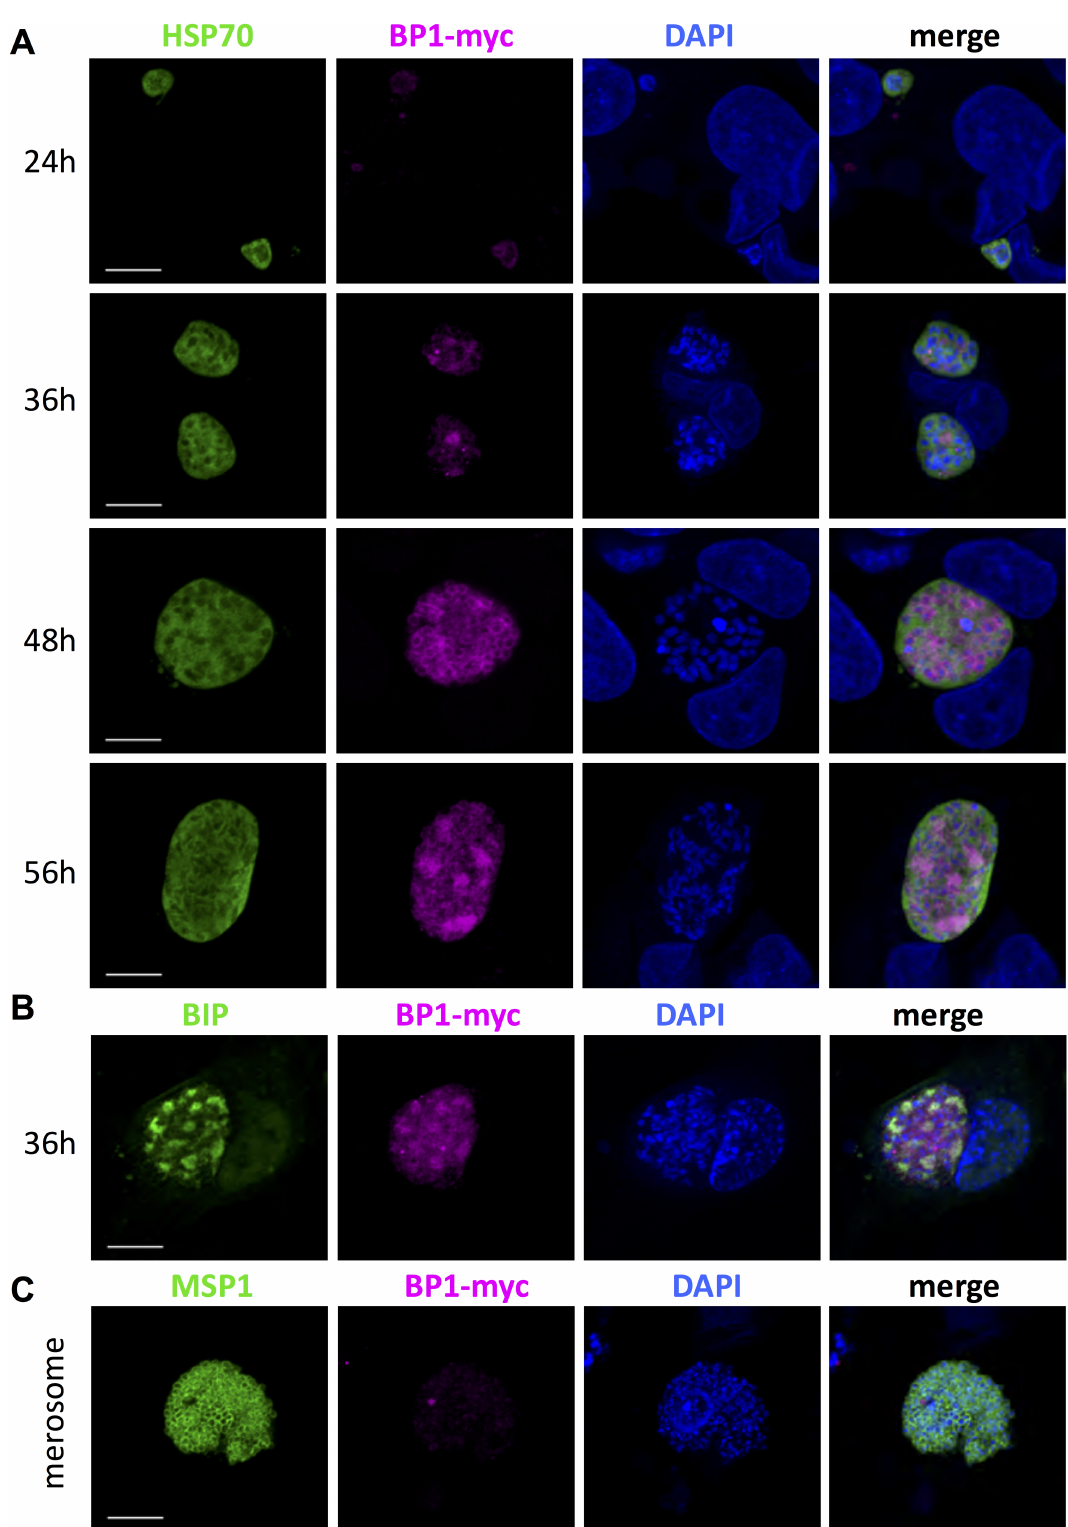
Fig 9. Expression of berghepain-1 in liver stage parasites. HepG2 cells infected with BP1-myc parasites, and merosomes collectedfrom these cultures, were fixed at the indicatedtimepointsand probedwith anti-c-myc